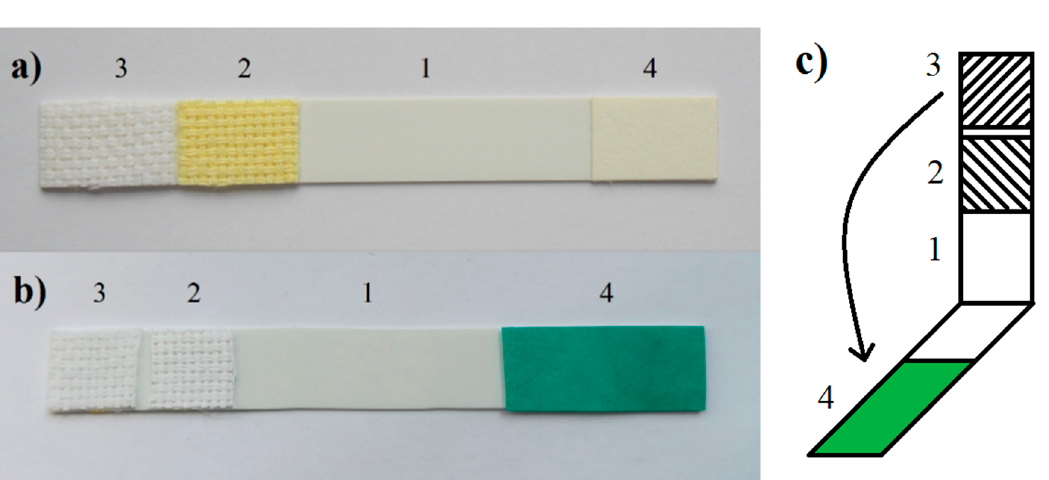
Figure 1. Photograph of ( a ) the Detehit biosensor and ( b ) the modified biosensor: plastic pad 1, etalon 2, fabric with the enzyme-indicator zone 3, paper with the substrate and indicator 4. The layout ( c ) shows how the opposite carriers are folded.